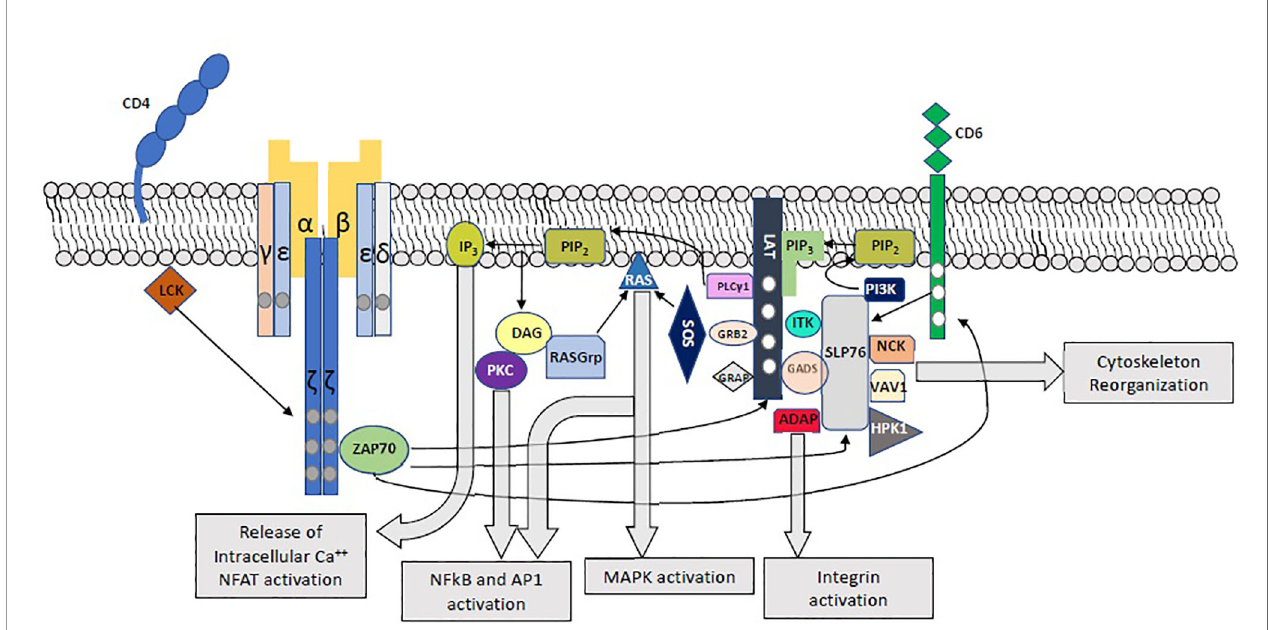
FIGURE 1 | Proximal T-Cell Activation Signaling. The main proximal signaling events following engagement of the TCR are depicted, including the assembly of the LAT and SLP-76 signalosomes and their downstream